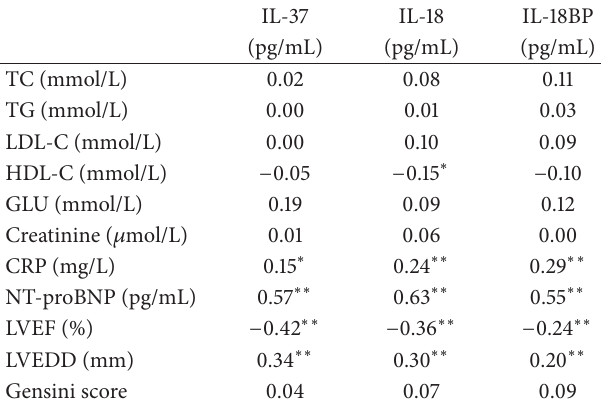
Table 5: Spearman’s correlation